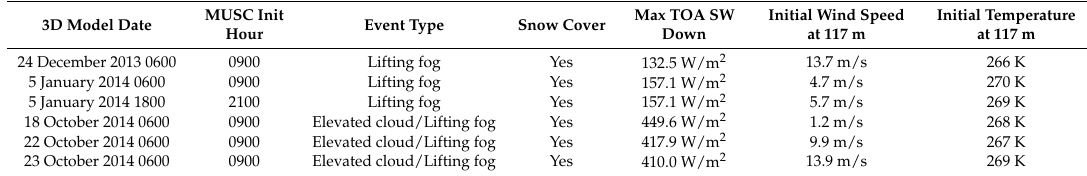
Table 1. Cases from which initial profiles were taken from the three-dimensional (3D)